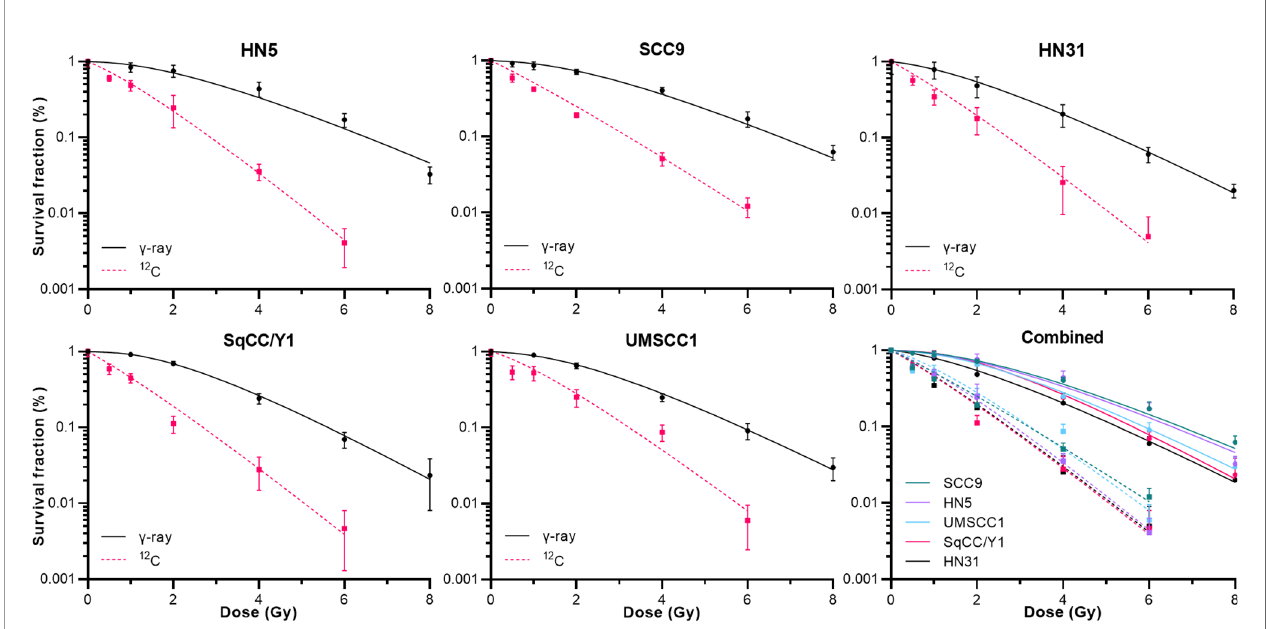
FIGURE 4 | Clonogenic cell survival for the 5 cell lines described in Table 2 when irradiated by either g -rays or 12 C at 400 Mev/u. The lower right panel shows all data